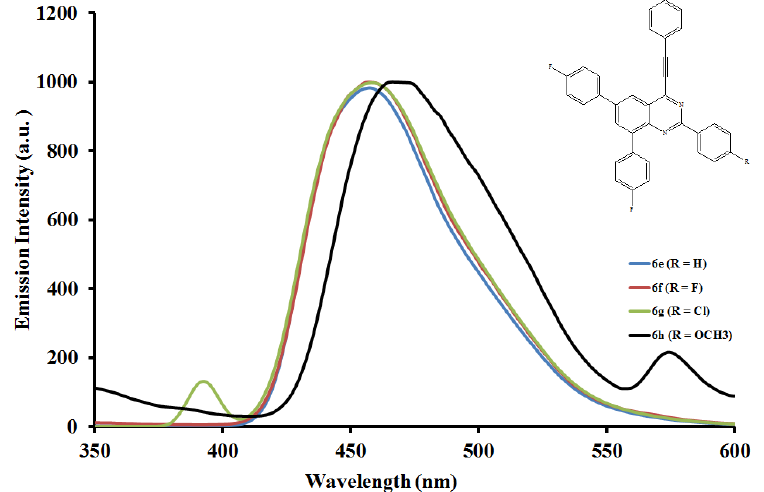
Figure 8. The emission spectra of compounds 6e – h ( λ ex = 400 nm) in DMF (0.022 mmol/L) at rt.